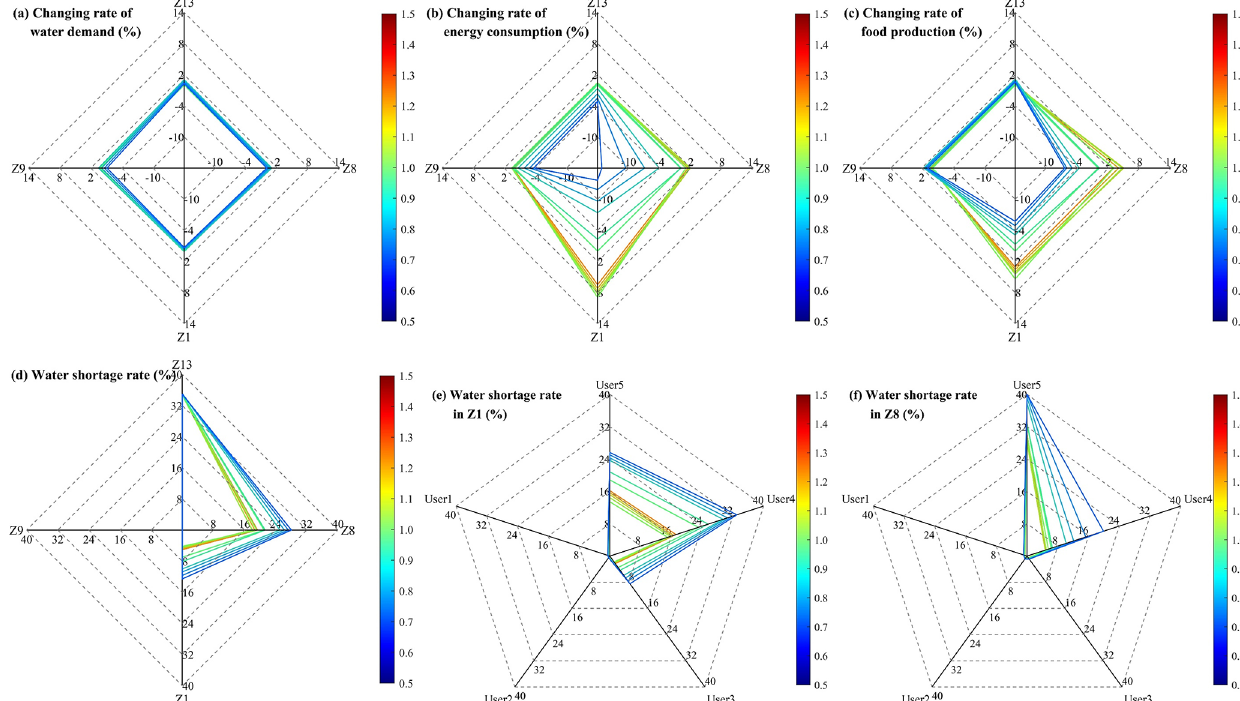
Figure 13. Socioeconomic variables with varied reservoir release multiplier in Z9, Z1, Z8, and Z13. (a) Changing rates of water demand. (b) Changing rates of energy consumption. (c) Changing rate of food production. (d) Water shortage rates. (e) Water shortage rates of water users in Z1 (user 1, 2, 3, 4, and 5 are related to municipal, rural, in-stream ecology, industrial, and agricultural users). (f) Water shortage rates of water users in